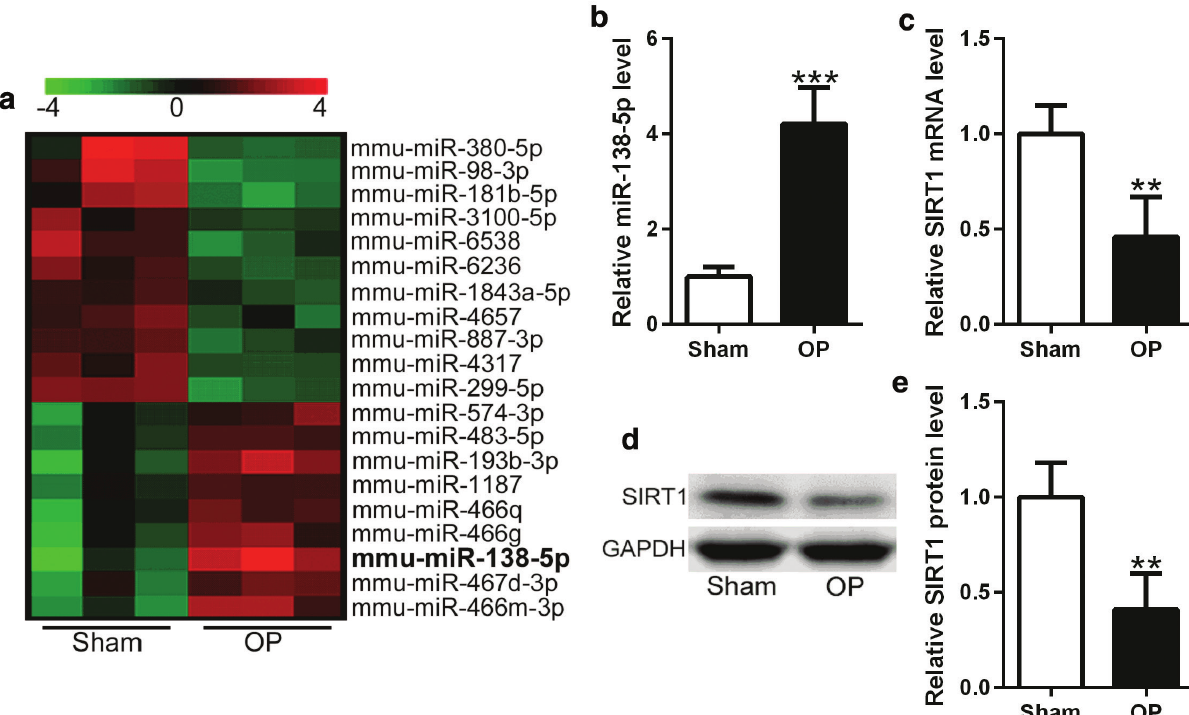
Fig. 1. Effects of cardiac surgery on hippocampal miRNA expression profiles in mice. (a) Heat map for differentially-expressed miRNAs analysis. Each column represents samples and each row represents miRNAs. Red represents upregulated miRNAs and green stands for downregulated miRNAs. The first three columns represent the expression of miRNAs in the Sham group, while the last three columns represent the expression of the corresponding miRNAs expression in the surgery group (OP). (b, c) qRT- PCR was used to measure the expressions of miR-138-5p (b) and SIRT1 mRNA (c) in hippocampus of mice with postoperative cognitive dysfunction (POCD). (d) SIRT1 protein expressions were analyzed by Western blotting. GAPDH was employed as a loading control. Relative expressions were normalized to Sham group (e). Sham: C57BL/6 wild-type mice with sham cardiac surgery; OP: C57BL/6 wild-type mice with cardiac surgery. Data were presented as ± SD. ** P < 0.01 and *** P < 0.001 com- pared to sham